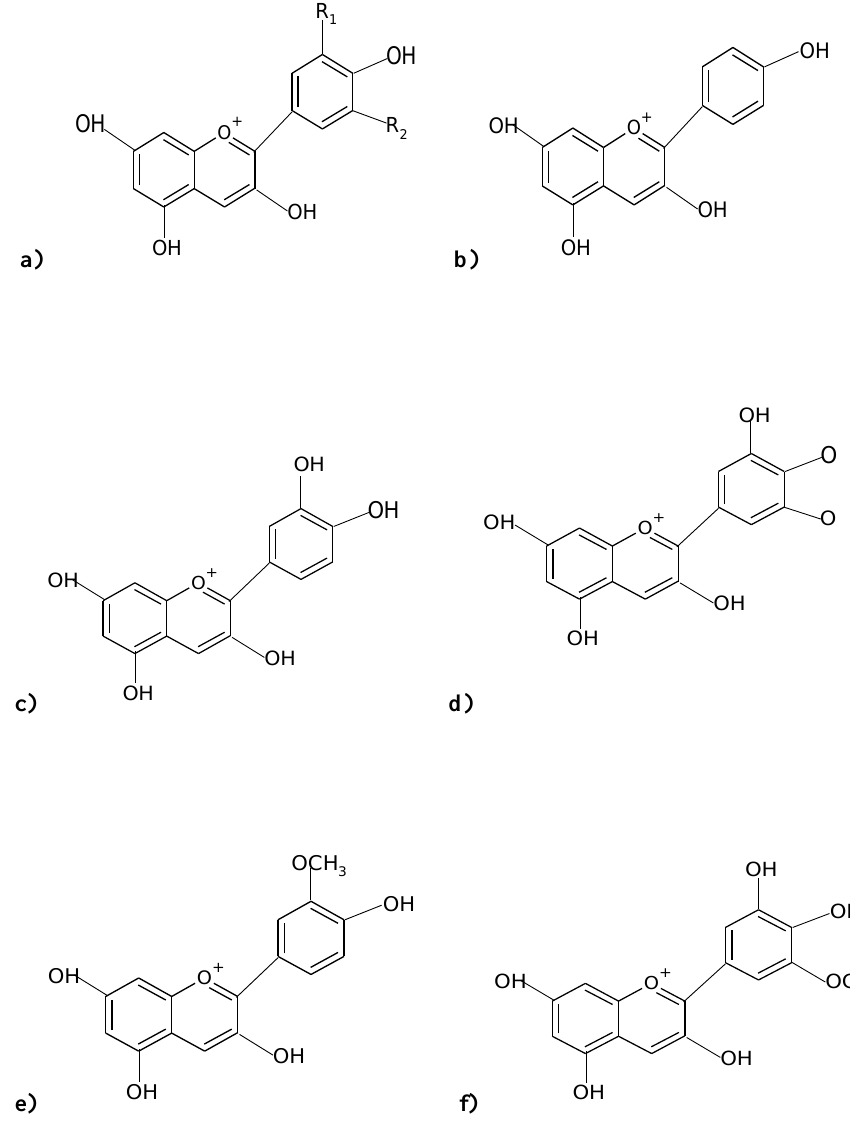
Figure 1. Chemical structures of predominant ACNs pigments present in various plants; ( a ) Basic structure of an ACN; ( b ) Pelargonidin; ( c ) Cyanidin; ( d ) Delphinidin; ( e ) Peonidin; ( f ) Petunidin.